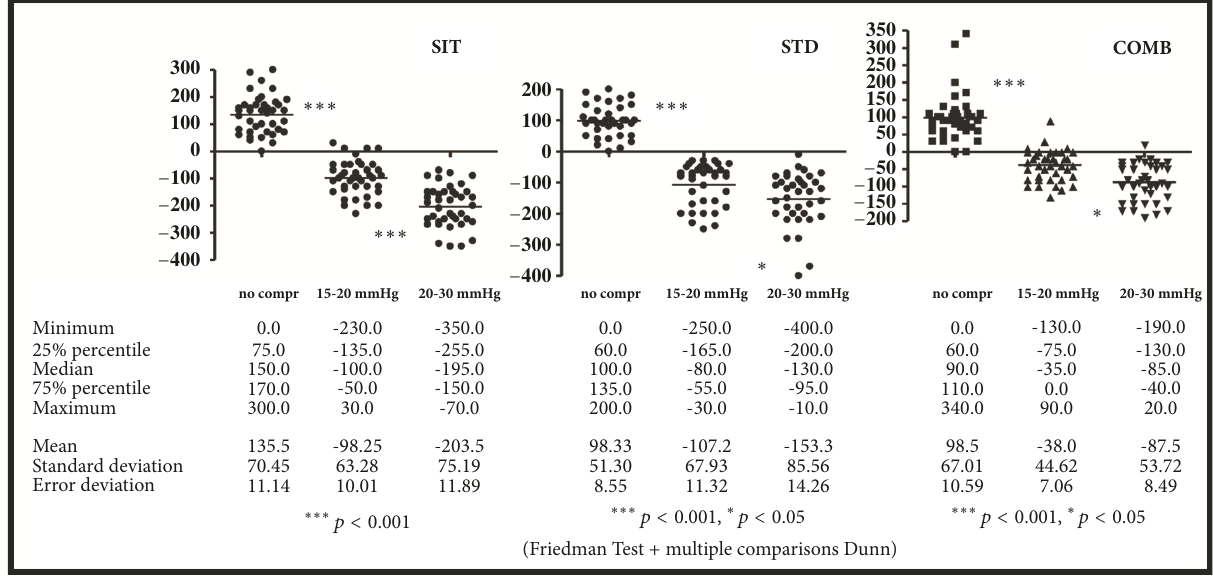
Figure 2: Volumetricdifferencesbetween morningand eveningmeasurestaken without compressionstockings(firstday)and aftera working